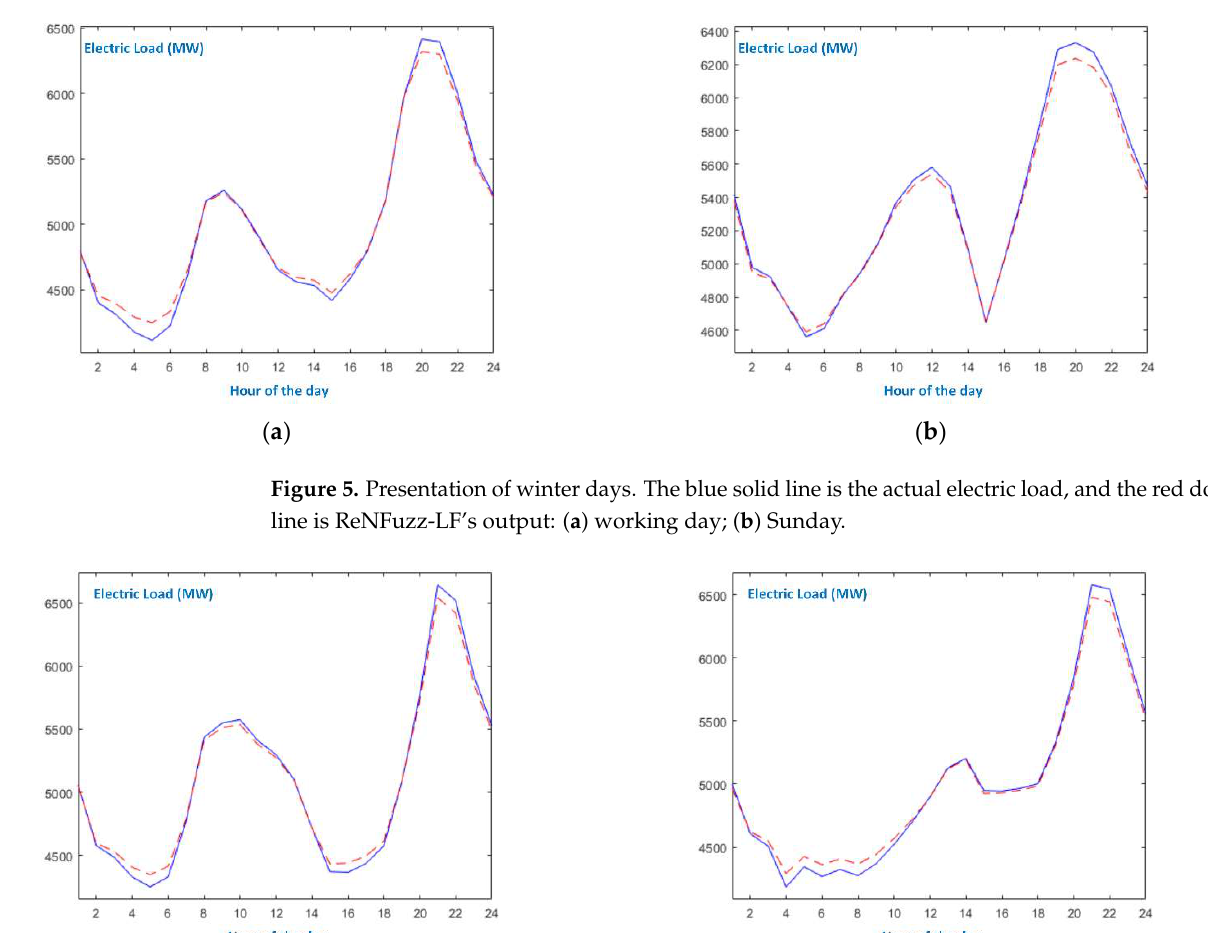
Figure 6. Presentation of spring days. The blue solid line is the actual electric load, and the red dotted line is ReNFuzz-LF’s output: ( a ) working day; ( b ) Sunday.